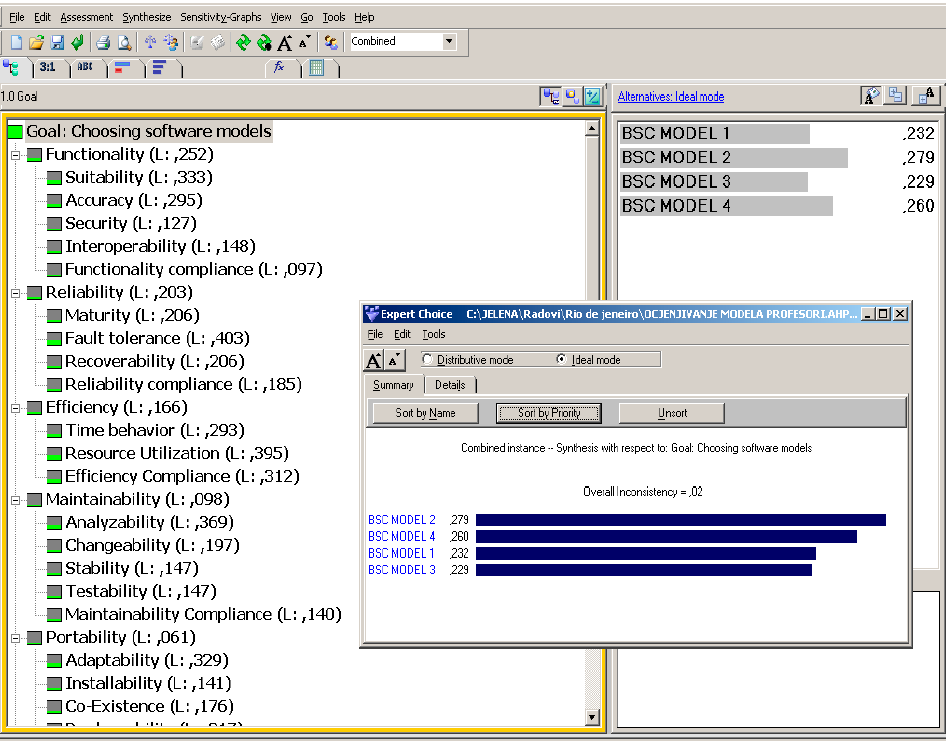
Figure 7. Results of evaluation of the BSC models obtained by Team 1 using the AHP method.